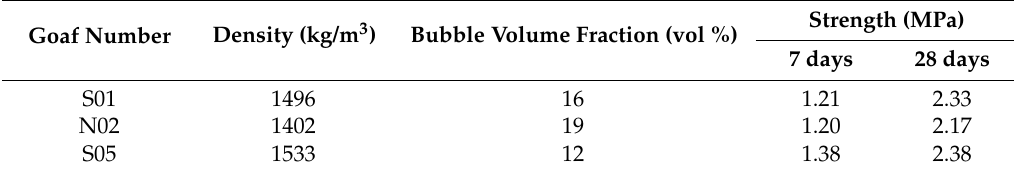
Table 6. The results of industrial